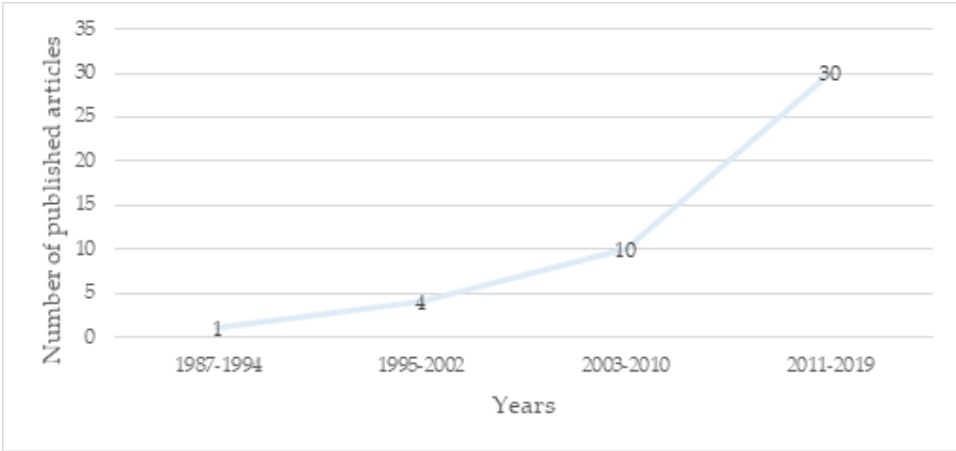
Figure 3. Graph of the number of publications across time.